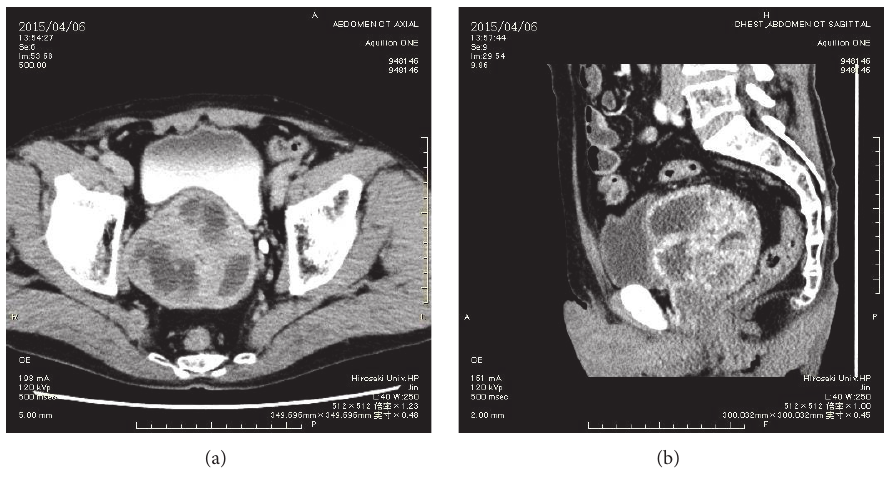
Figure 1: CT scan image of prostatic tumor. (a) Axial image. (b) Sagittal image.